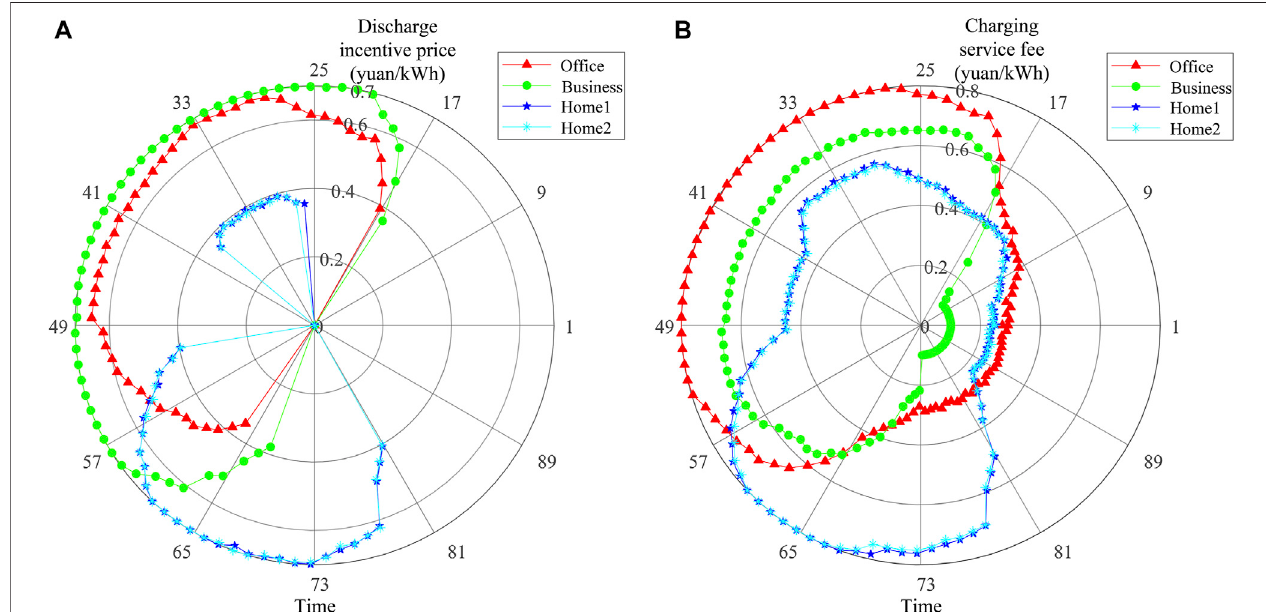
FIGURE 6 | (A) EV discharge incentive dispatching price. (B) EV charging service